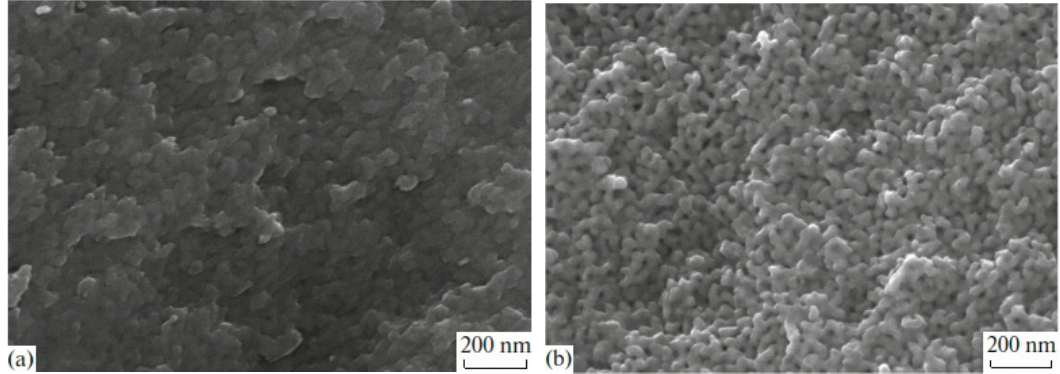
Figure 1. SEM images from cleavages for porous glasses MIP ( a ) and MAP ( b ) [27].